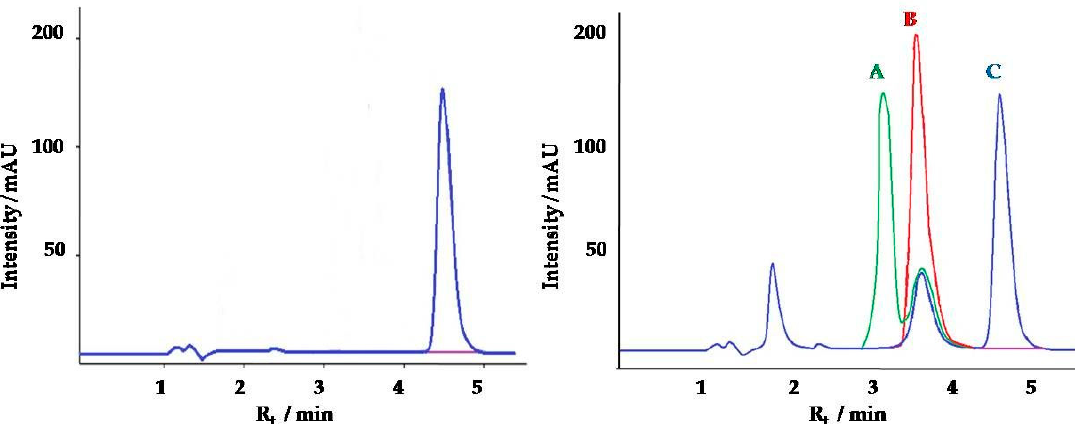
Figure 1. ( a ) Chromatogram of creatinine standard (10 µg/mL, 0.1% TFA, R t = 4.6 min); ( b ) Chromatograms of creatinine extracted from pig urine samples with different TFA content in mobile phase: A—0.01% TFA, R t = 3.1 min, B—0.05% TFA, R t = 3.6 min, C—0.1% TFA, R t =4.6 min.